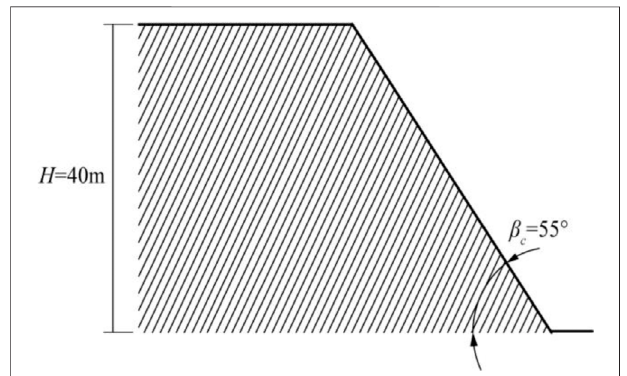
FIGURE 7 | Critical instability length.